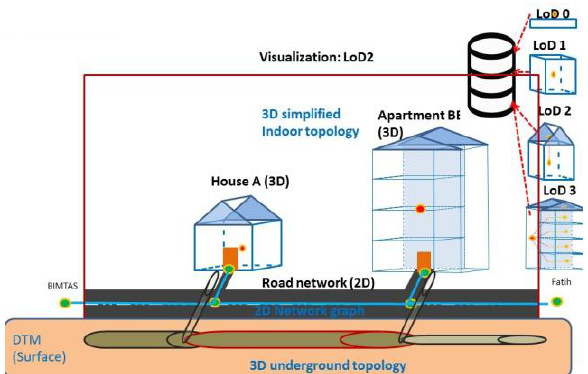
Figure 17. Illustration on unify topological modelling for utility (single scale, road – 2 LoDs, and bulding 3 LoDs. Example of Pseudo/conceptual flow Block selection (in Viewer, e.g. Building & Pipeline in LoD1 )  query on LoD info (e.g. 2 LoD options, selection LoD2)  select/query on the pipe network  extract info (estimated solar energy in LoD3) to the Viewer (LoD1).